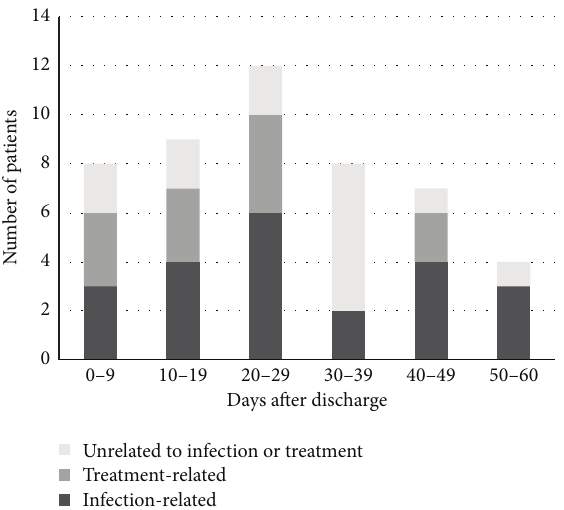
Figure 1: Time to readmission or emergency department use after discharge,groupedbycause.Infection-relatedcausesincluderelapse or treatment failure. Treatment-related causes refer to complications related to OPAT, such as catheter problems or allergic/adverse drug reactions. Overall median time to event was 25 days (interquartile range: 13 to 38